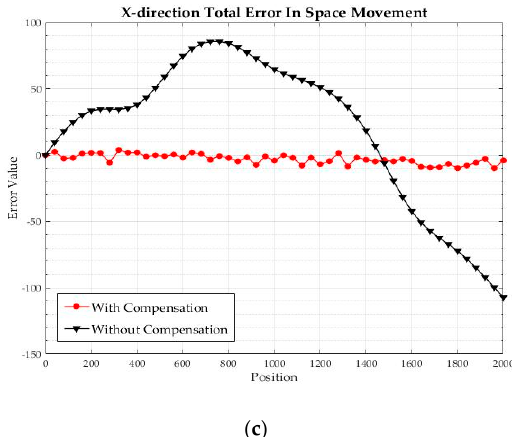
Figure 11. Compensation experiment result. ( a ) Residual Y-direction straightness error in X-direction movement before and after compensation; ( b ) Residual Z-direction straightness error in X-direction movement before and after compensation; ( c ) Residual X-direction total error before and after compensation.